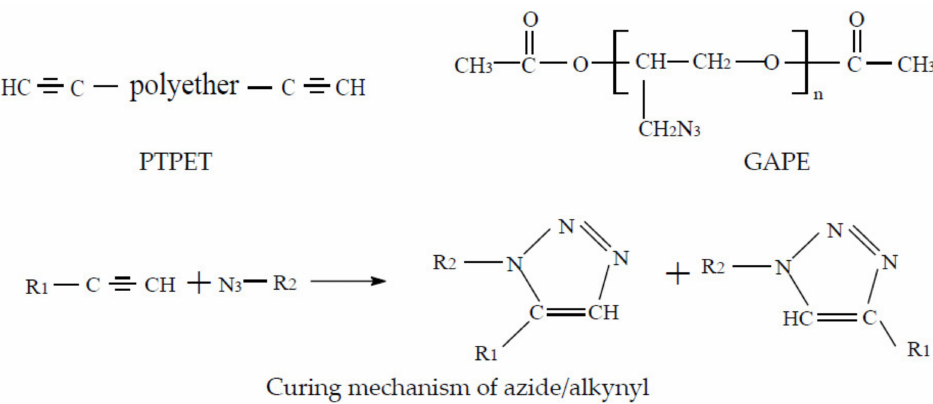
Figure 9. The reaction mechanism of azide and